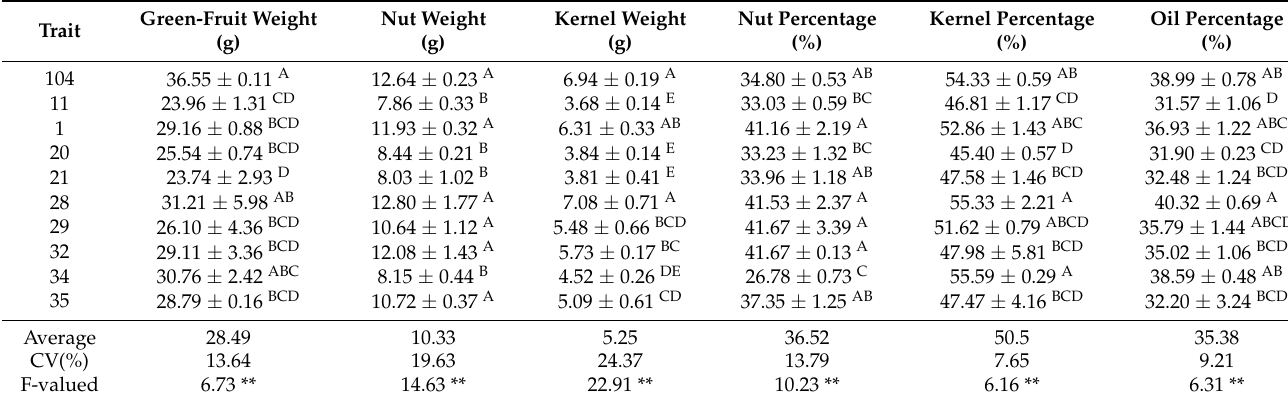
Table 1. Fruit traits of 10 pecan